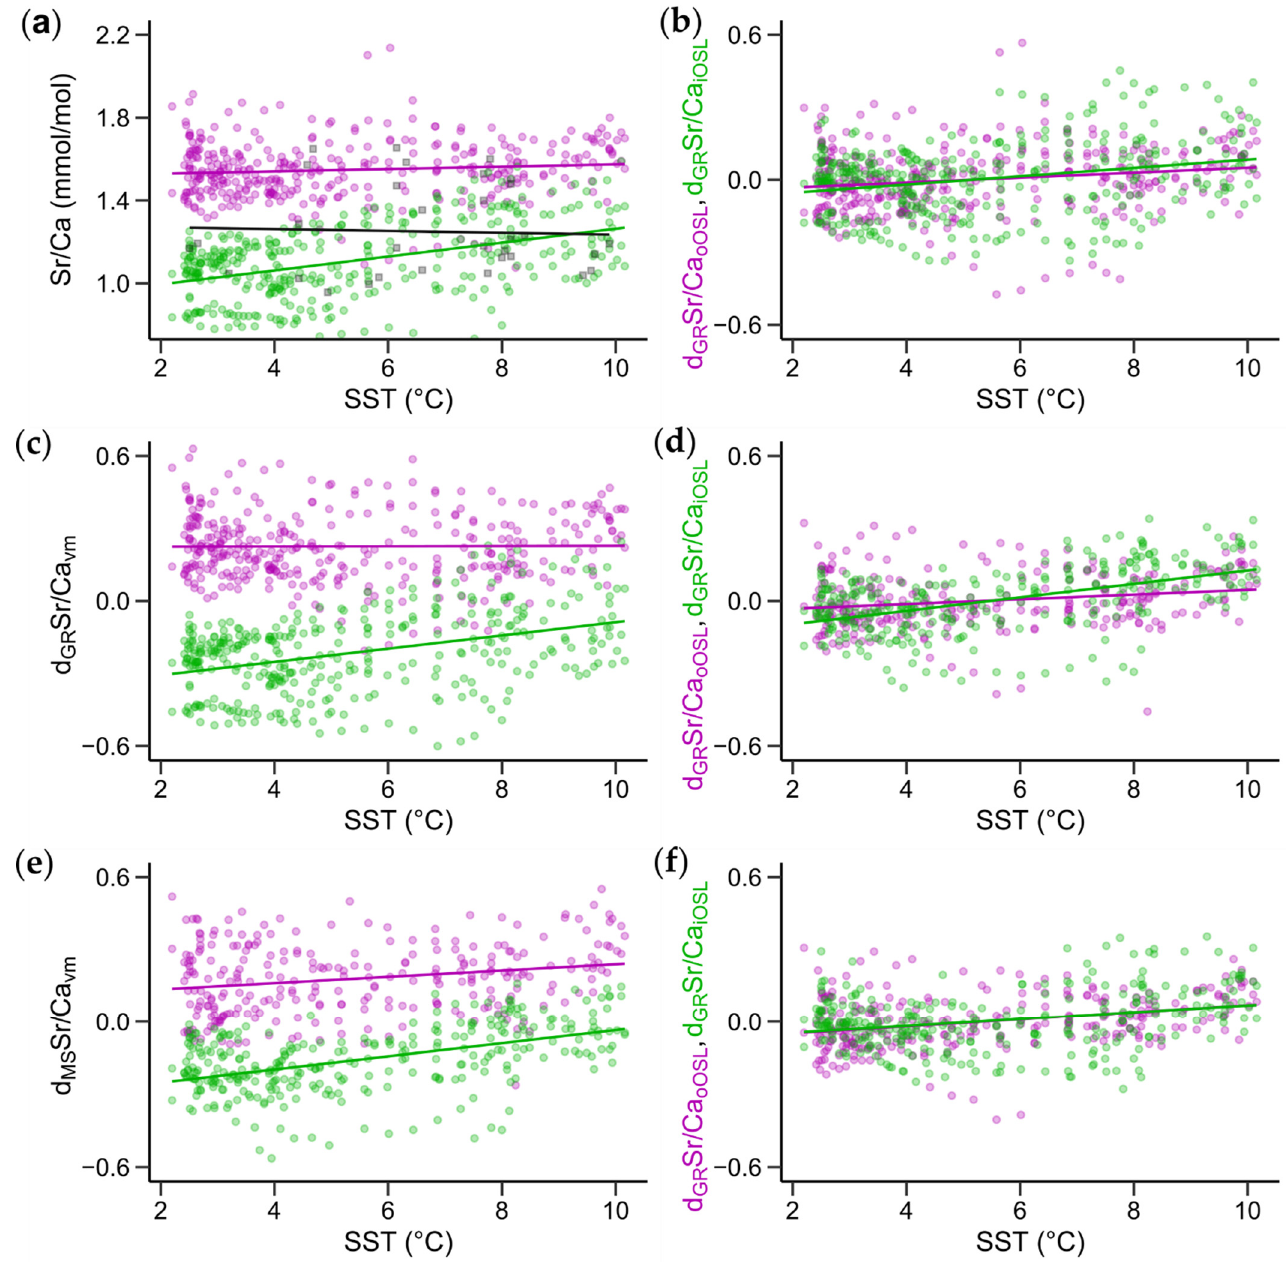
Figure 8. Relationships between shell Sr/Ca data of Arctica islandica and SST. Acronyms and color coding as in caption of Figure 3. ( a ) Undetrended Sr/Ca data; ( b – f ) detrended Sr/Ca data. ( a ) Shell Sr/Ca of the oOSL and iOSL are weakly positively correlated to sea surface temperature, and those from the hinge are not. ( b , c ) Growth rate (GR)-detrended Sr/Ca data. ( b ) Sublayer-specific detrending, ( c ) detrending based on all ventral margin data. ( d , e ) BMU area (MS)-detrended Sr/Ca data. ( d ) Sublayer-specific detrending, ( e ) detrending based on all ventral margin data. ( f ) Double-detrended Sr/Ca chronologies (growth rate + BMU area detrending, layer-specific as in ( a , c )). While the growth-rate-detrended Sr/Ca data showed only extremely weak though statistically significant positive correlations with SST (r = 0.18 to 0.27, p < 0.001; Figure 8a,b and Table 2), the BMU-area-detrended Sr/Ca data of the iOSL data were more strongly tied to SST (r = 0.51, p < 0.001; Table 2). However, BMU-area-detrended Sr/Ca values of